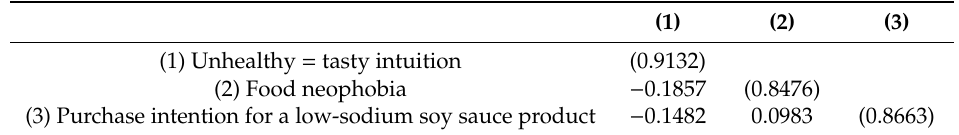
Table 6. Correlations of the latent variables and the square root of the average variance extracted from the first experiment: soy sauce products.